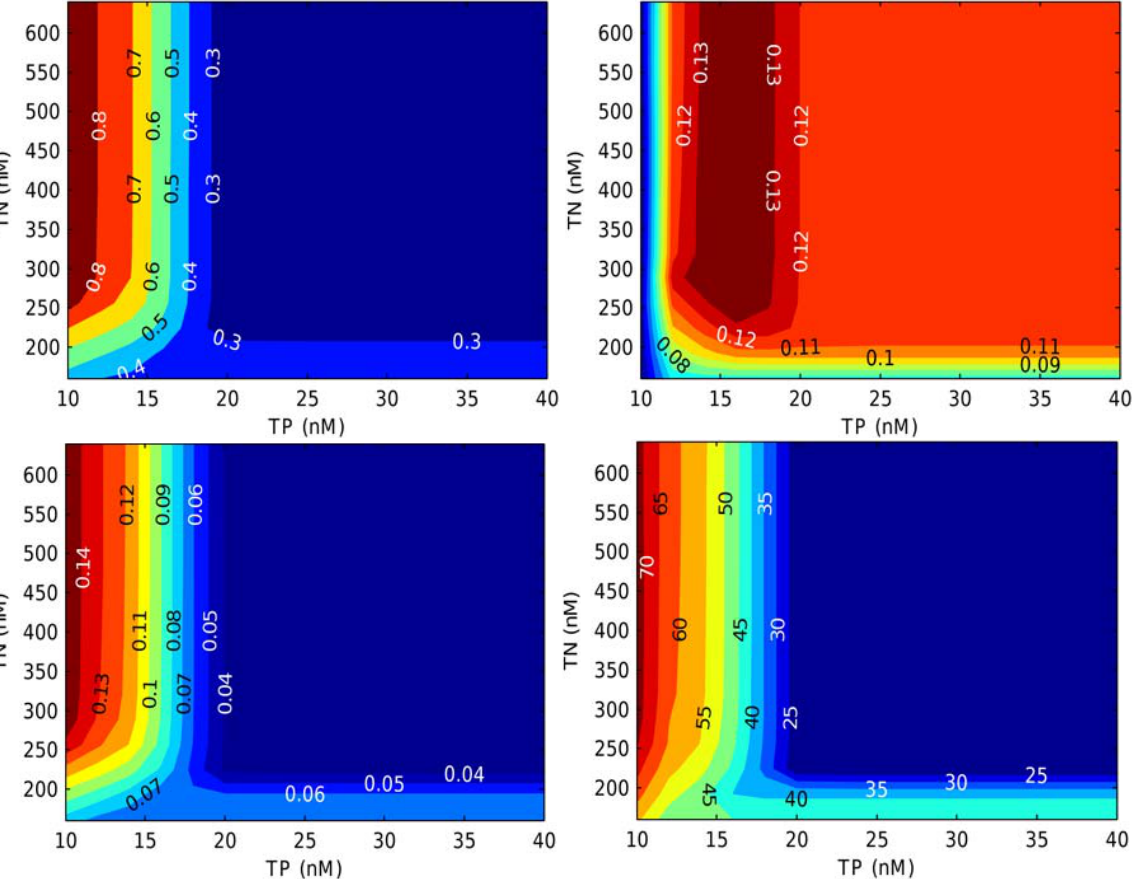
Fig. 6. Gross primary production (GPP), Net primary production (NPP), Chlorophyll concentration and photosynthetic extracellular released (PER) as a function of TN and